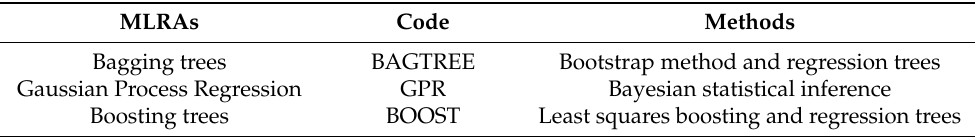
Table 3. Machine learning regression algorithms (MLRAs) used in this